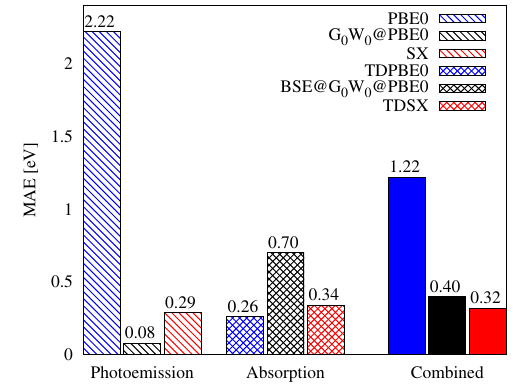
FIG. 4. MAE for (from left to right) the ionization potentials (photoemission) of Thiel ’ s test set (with the exception of propanamide because of the lack of experimental data) predicted by the highest occupied molecular orbital energy computed using PBE0, G 0 W 0 @ PBE 0 , and the screened exchange constant functional (SX); the lowest optical singlet transitions predicted by the SX functional [TDSX, i.e., time-dependent density func- tional calculations using the SX functional, Eq. (10)], TDPBE0 and PBE0 with many-body perturbation theory corrections (BSE @ G 0 W 0 @ PBE 0 ) TDPBE0 and BSE @ G 0 W 0 @ PBE 0 are taken from Ref.